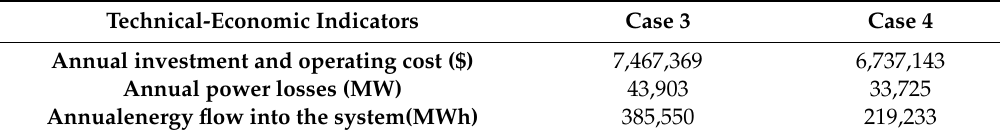
Table 4. Comparison of planning results between Case 3 and Case 4.